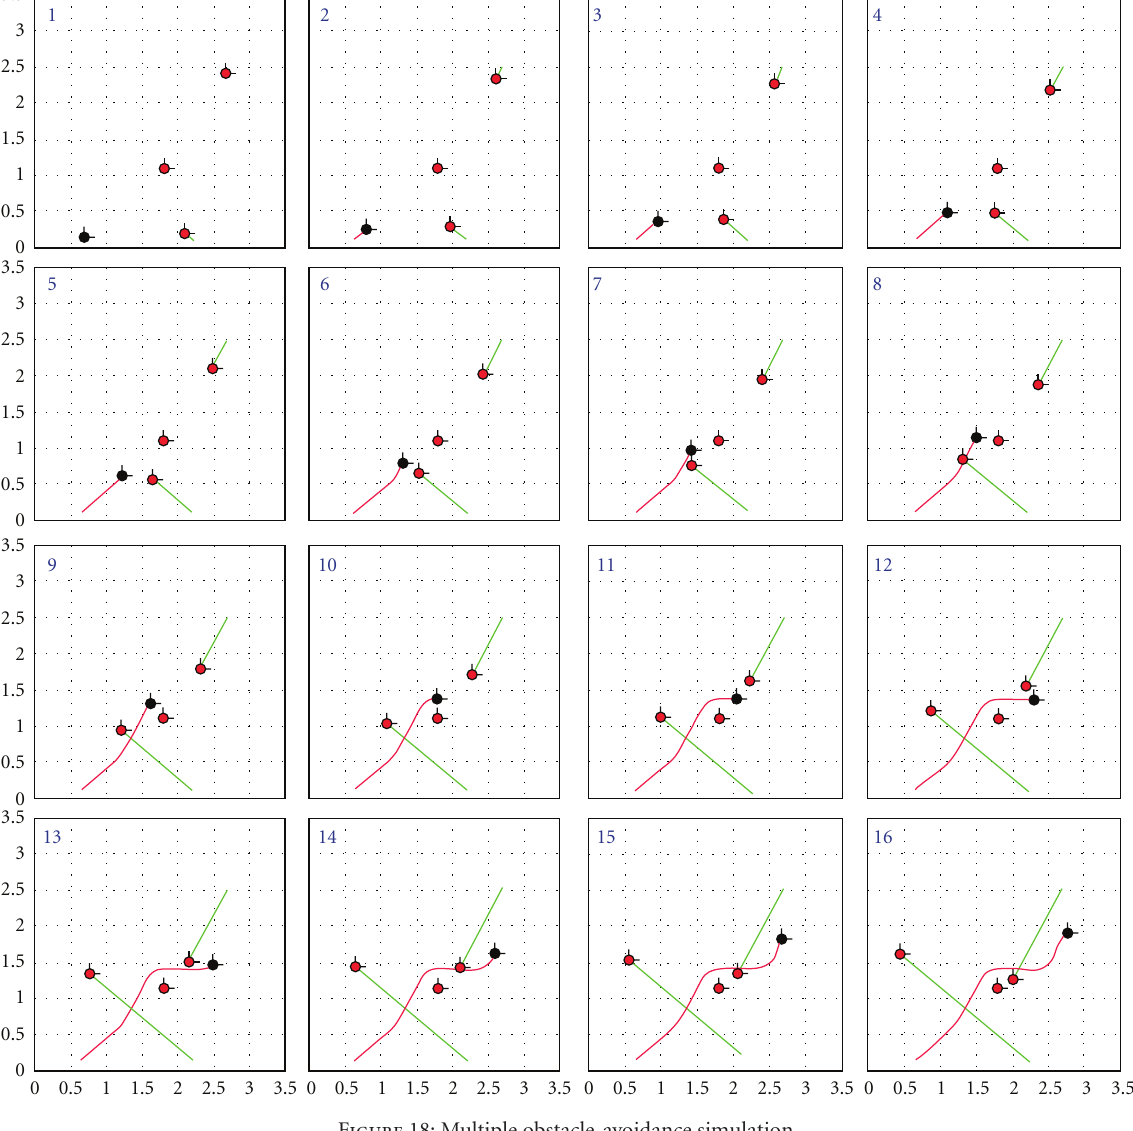
Figure 18: Multiple obstacle-avoidance simulation.